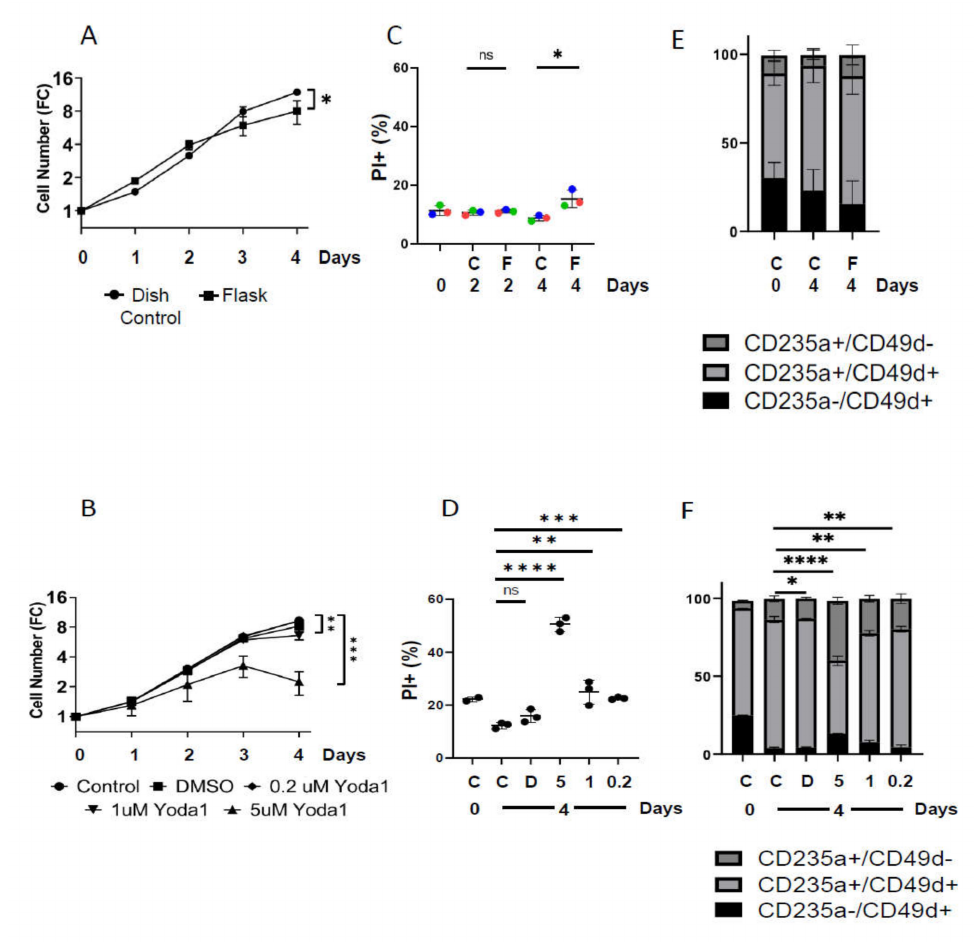
Figure 1. Mechanically stimulated and Yoda1-treated erythroblasts proliferation is impaired. Erythroblasts were cultured in flasks on the orbital shaker at 300 RPM (Flask: F) and in dishes in static control condition (Dish Control: C) for 4 days ( A , C , E ). In parallel, erythroblasts were cultured in absence (Control: C) or the presence of 0.2 µ M (0.2), 1 µ M (1) and 5 µ M (5) Yoda1 or the solvent DMSO (DMSO: D) ( A , B , D , F ) Cell counts were assessed daily, cell number was maintained below 1,5 × 106 by daily dilution and cumulative cells were calculated (depicted as fold change (FC)). ( C , D ) Cell death was assessed by Propidium Iodide (PI) staining at day 0, 2, or 4 for orbital shaking, and at day 0 and 4 for Yoda1 treatment. Significance refers to the most mature CD235a + /CD49d- population. ( E , F ) Erythroblasts were stained with Pacific Blue-labeled anti CD49d and PE-labeled anti CD235a (GPA) antibodies and analyzed on the flow cytometer. Expression is plotted as percentage of more immature (black; CD235a - /CD49d + ), and more mature erythroblasts (light grey; CD235a + /CD49d + and dark grey; CD235a + /CD49d - ). All experiments were performed in triplicates, error bars indicate standard deviation. For orbital shaker experiments paired t-tests, and for Yoda1 experiments unpaired t -tests were performed to assay significance between conditions (* p < 0.05; ** p < 0.01; *** p < 0.001; **** p <